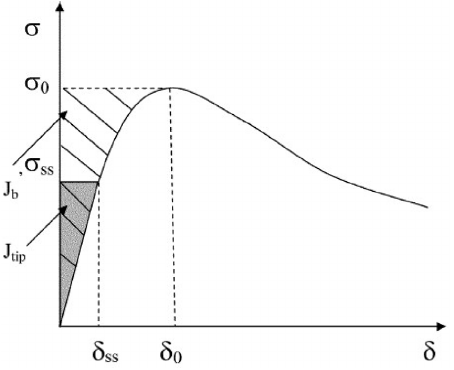
Figure 7. Typical - σ δ constitutive relation for the cementitious composite [38]. Figure 7. Typical σ - δ constitutive relation for the cementitious composite